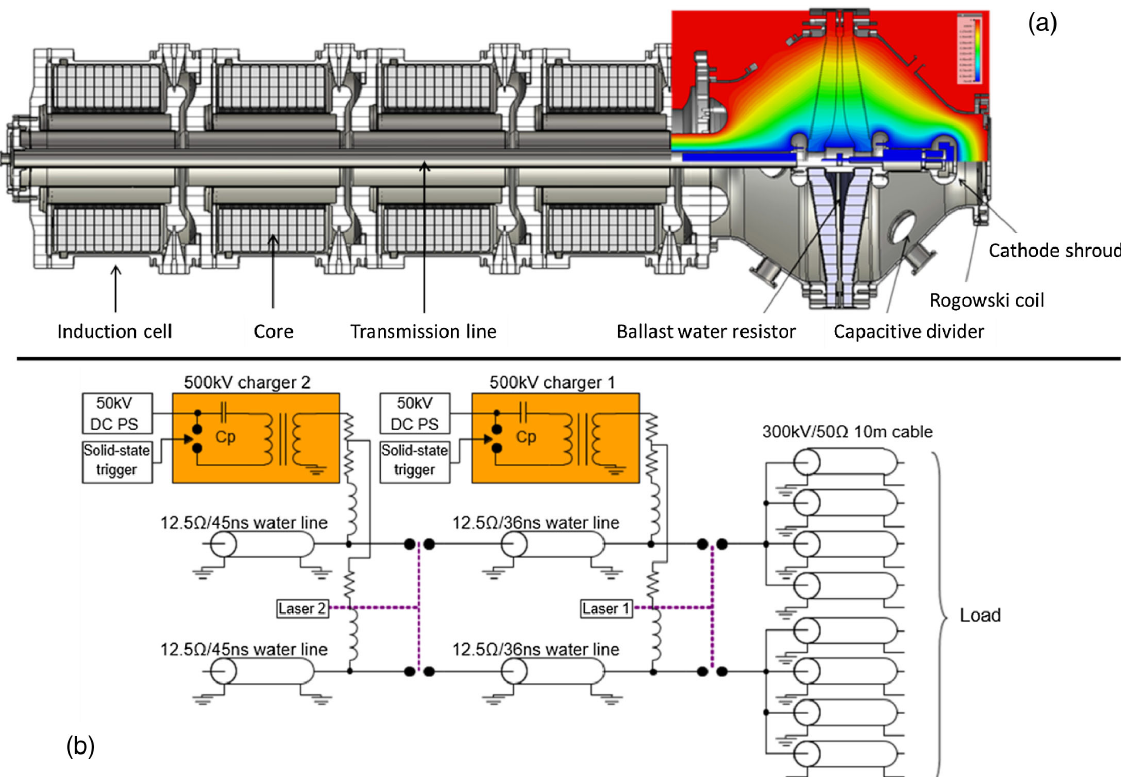
FIG. 1. (a) Cut view of the Mi2 IVA including four ferrite induction cells, ballast radial resistor, and vacuum diode enclosure. Electrostatic potential distribution in the diode region [24] (right part of the figure). (b) 250 kV dual-pulse driver based on laser-triggered series water pulse forming